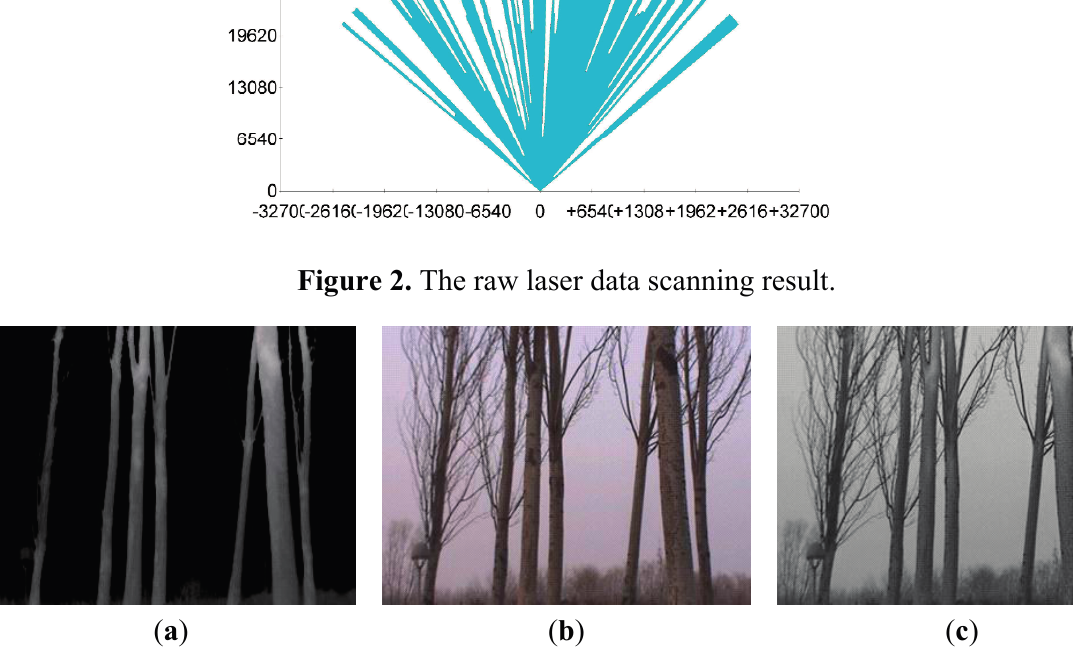
Figure 3. The corresponding visual information of the forest area: a visible image ( a ); an infrared thermal image ( b ); a fused image with clarity enhanced and more abundant captured information ( c